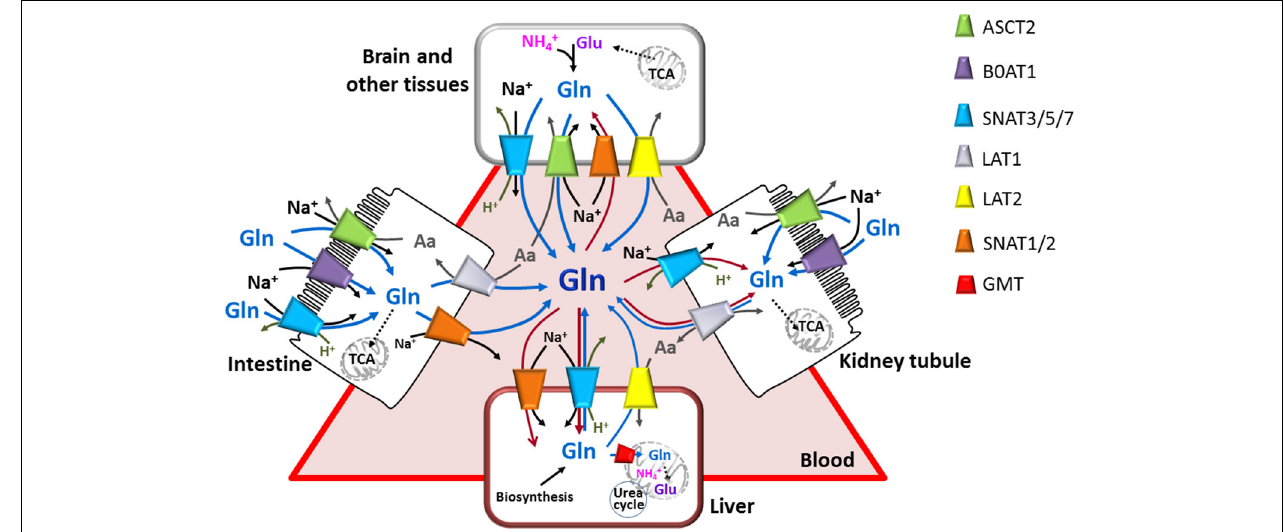
FIGURE 2 | The glutamine transporter network. Interplay among epithelial polarized cells (apical membrane is depicted as brush-border; basolateral membrane is in contact with blood) and other cells. Glutamine transporters are indicated in the figure with different colors. Arrows indicate glutamine fluxes from (red) or toward (blue) blood or from lumen to epithelial cells (blue); black